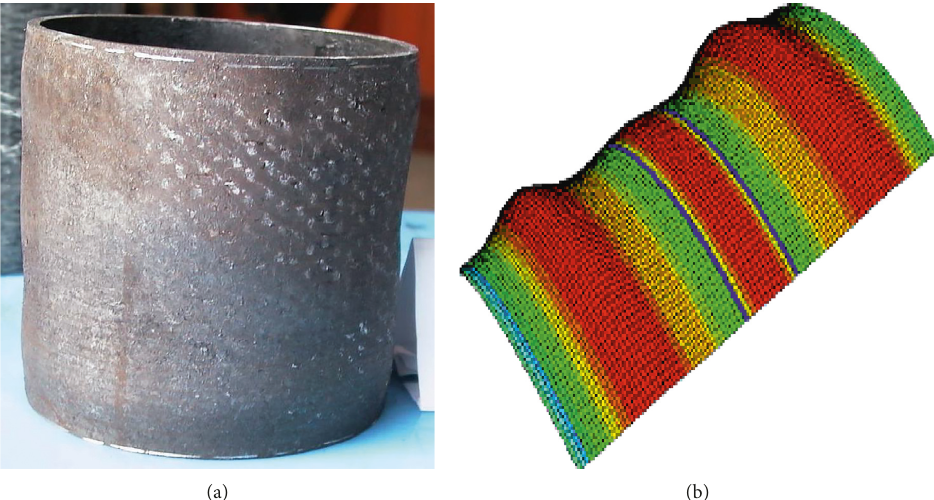
Figure 16: Experimental obtained extension mode (composite removal) and numerical one (Von Mises stresses in the steel layer) of one and two layers of CFRP.